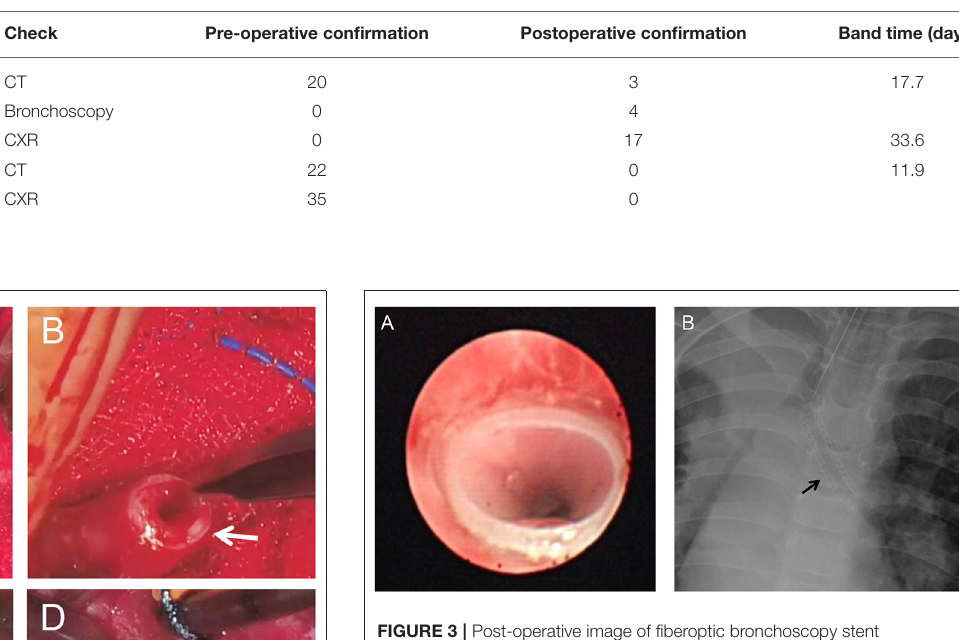
TABLE 2 | Confirmation of the diagnosis and mechanical ventilation duration.